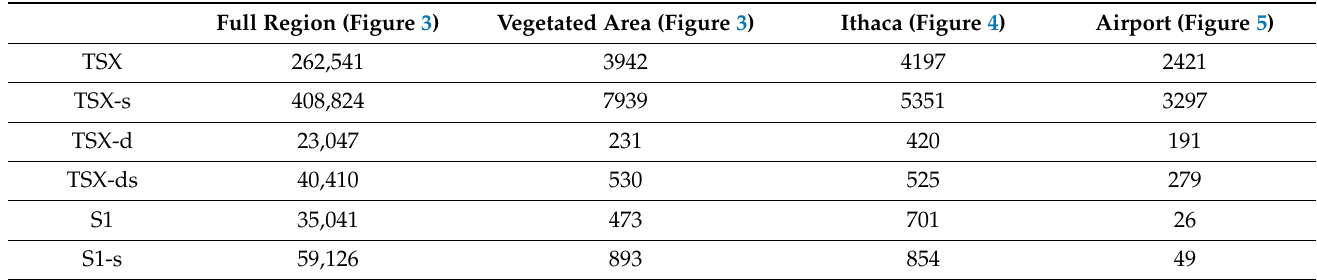
Table 1. Number of PS points according to region and